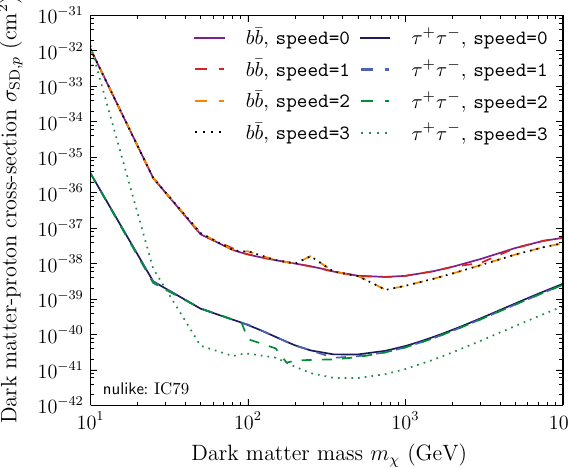
Fig. 4 Comparisonofdifferentlimitsobtainedfrom79-stringIceCube data using nulike , with different speed settings. The default is 3 ,